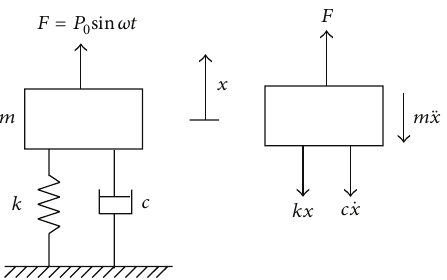
Figure 4: Mechanical model of electromagnetic vibration